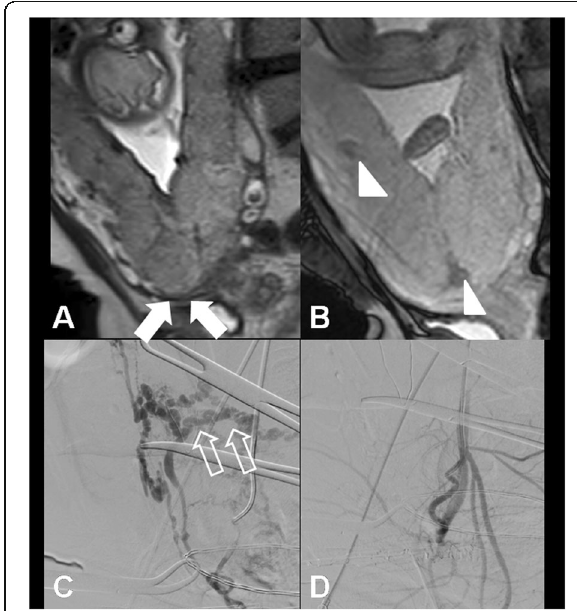
Fig. 2 A 33-week pregnant female with suspected placenta accreta on USG. a MR imaging T2W sagittal image shows type 4 placenta previa with loss of myometrial interface (arrow) confirming placenta accreta. b T2WI shows dark bands (arrow heads). c Pre-embolization angiogram shows hypervascularity arising from the uterine artery (open arrows). b Post embolization uterine angiogram shows reduction in hypervascularity. The fetus was delivered by LSCS, and the placenta was left in situ that got expelled later